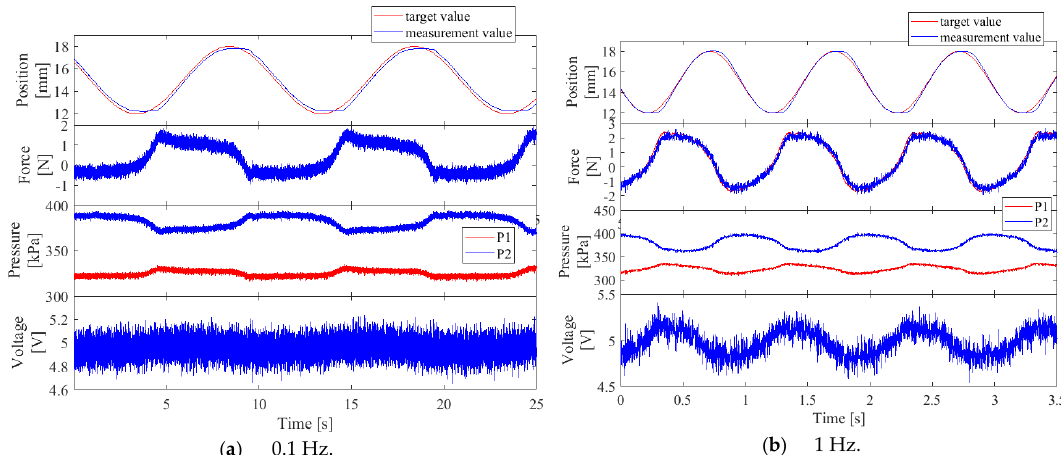
Figure 15. Experimental results of piston control of a pneumatic cylinder with the developed pinch- type servo valve. Figure 16. Experimental results of piston control of a pneumatic cylinder with the spool-type valve.